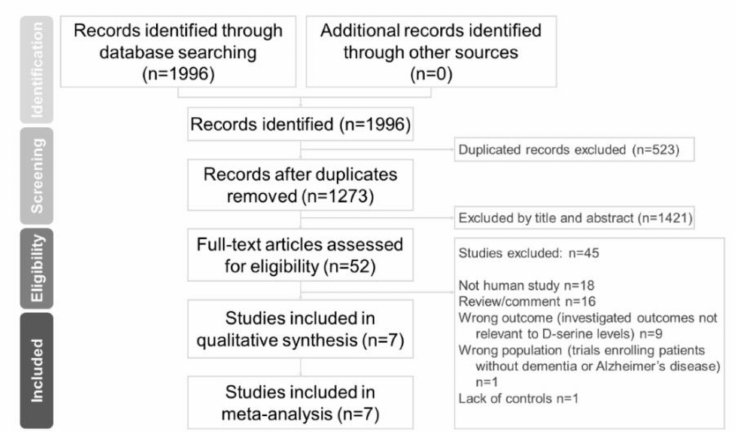
Figure 1. Preferred reporting items for systematic reviews and meta-analyses (PRISMA) flow diagram for searching and identifying included studies. Database: PubMed ( n = 1996), Cochrane central register of controlled trials ( n = 721), and Cochrane database of systematic reviews ( n = 2). Keywords: ( d -serine OR D-amino acid* OR biomarker) AND (dementia OR Alzheimer*) AND (serum OR plasma OR blood OR CSF) AND trial. Date: available until 23 November